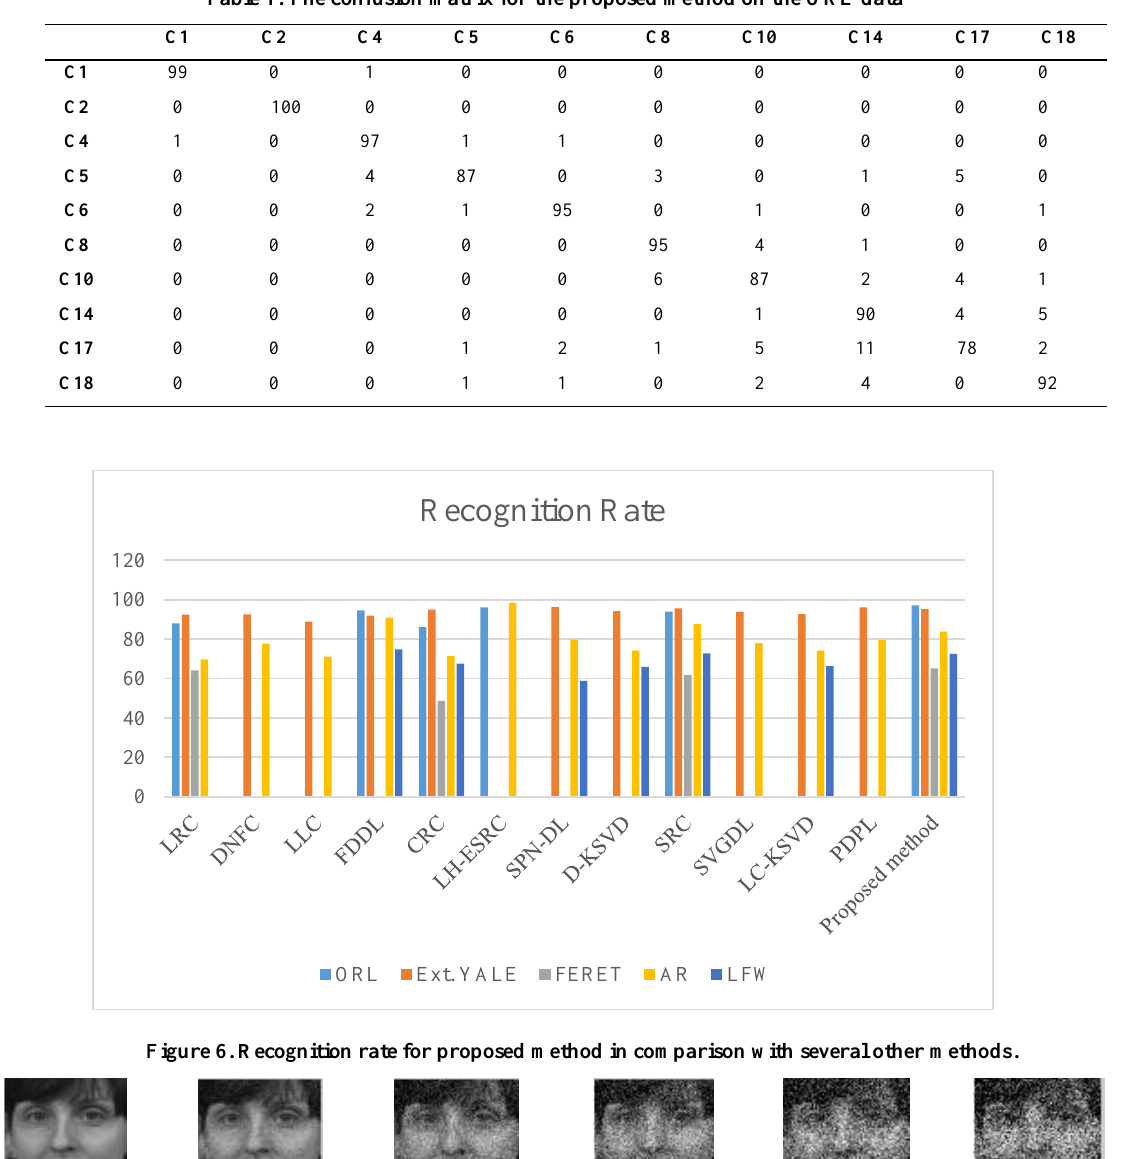
Table 1. The confusion matrix for the proposed method on the ORL data